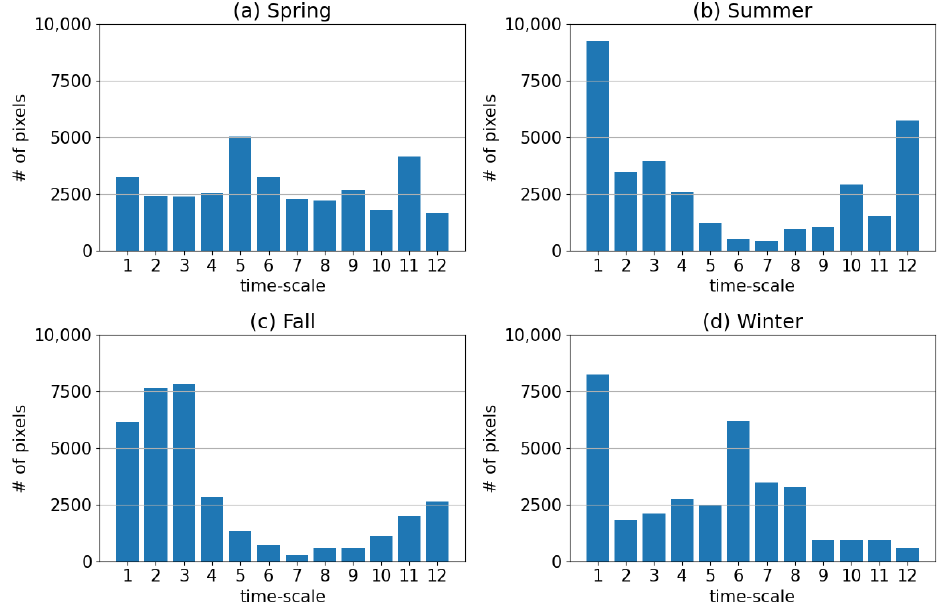
Figure 4. Histogram of optimal timescale of SPI for ( a ) spring, ( b ) summer, ( c ) fall and ( d ) winter.